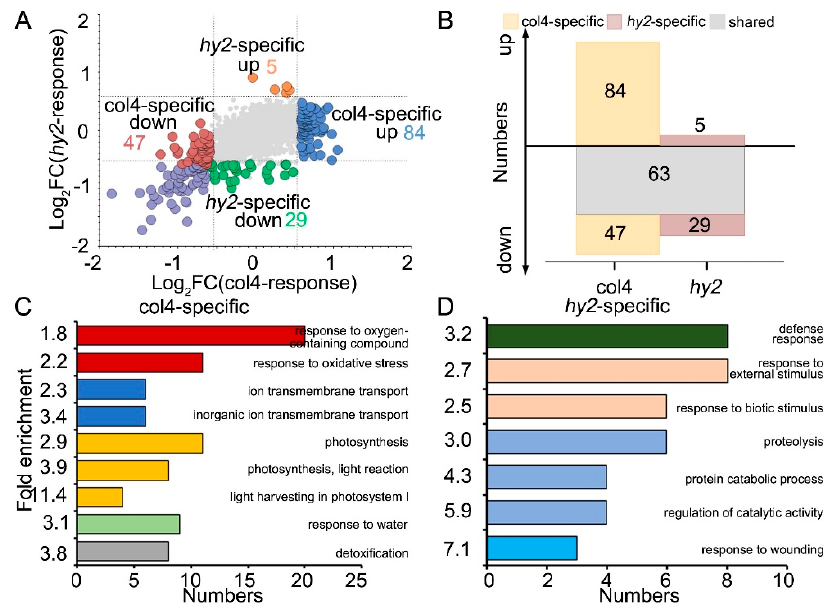
Figure 4. Function analysis of DRPs. ( A ) Protein expression pattern of col4 and hy2 shared quantified proteins. The abscissa and ordinate represent the protein pattern of col4 and hy2 mutant, respectively. Color denotes proteins regulated similarly by col4 and hy2 (grey), or specifically by col4 (blue and red) or hy2 (orange and green). ( B ) The number of distinct proteins significantly up- or downregulating col4 and hy2 mutant. Color denotes proteins regulated similarly by col4 and hy2 (grey), or specifically by col4 (orange) or hy2 (brown). ( C ) The GO enrichment analysis of col4-specific response proteins. ( D ) The GO enrichment analysis of hy2 specific response proteins.